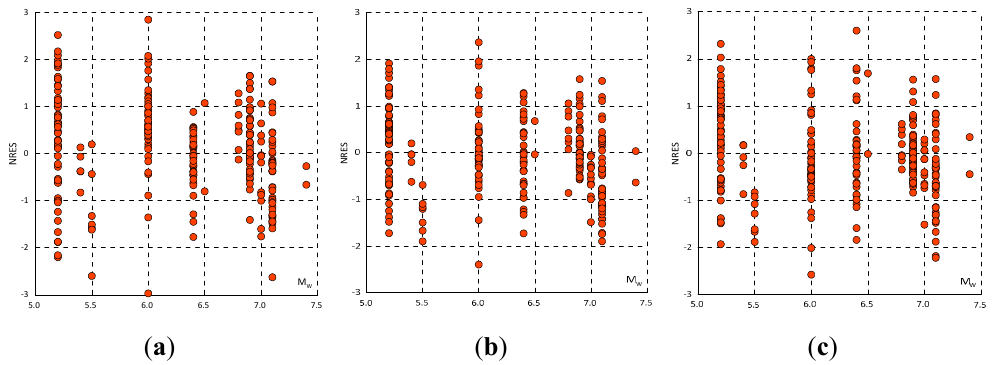
Figure 20. Distribution of normalized residuals with magnitude, set 3. ( a ) T = 0.30 s; ( b ) T = 1.00 s; ( c ) T = 1.50 s.